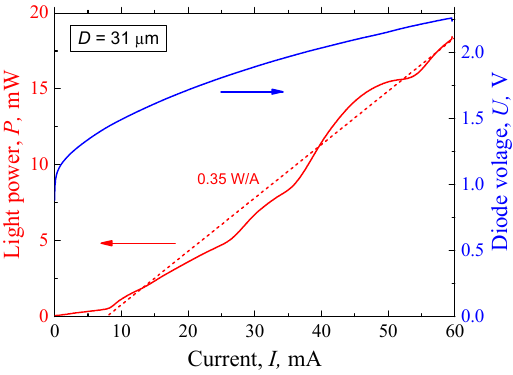
Figure 17. Total power in free space and voltage of a 31 µm in diameter MD laser as a function of current. Dotted line: 0.35 mW/mA.